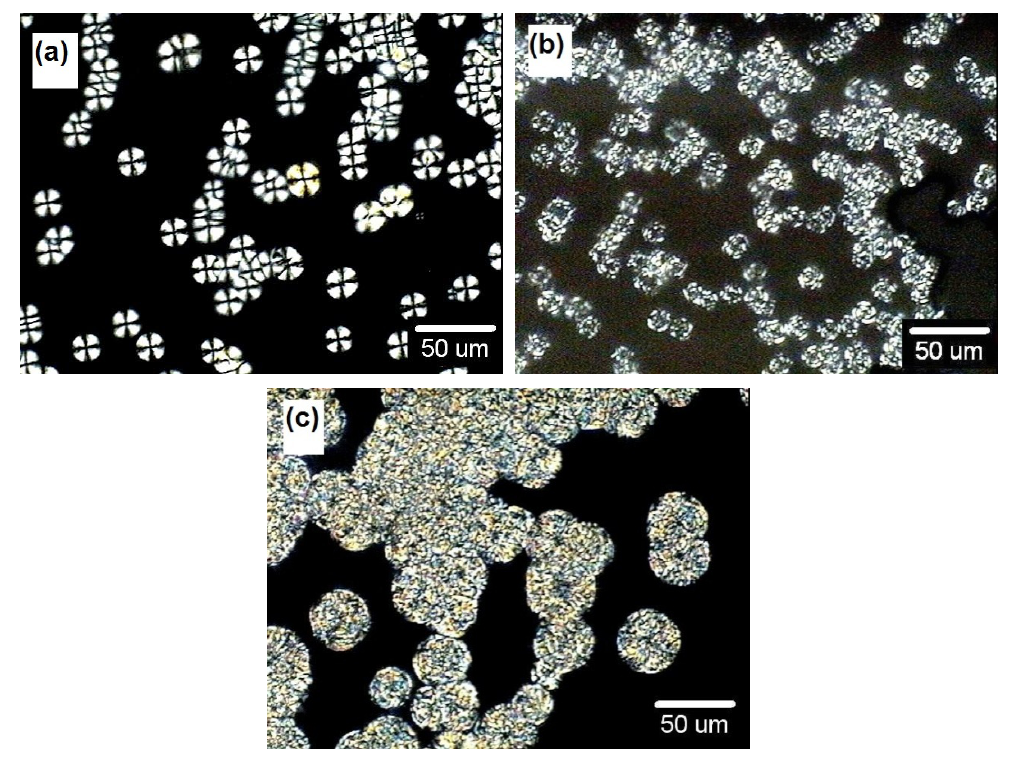
Figure 3. POM micrographs of isothermally crystallized PET-HMw at ( a ) 200 °C and 1 min; ( b ) 220 °C and 5 min; and ( c ) 230 °C and 12